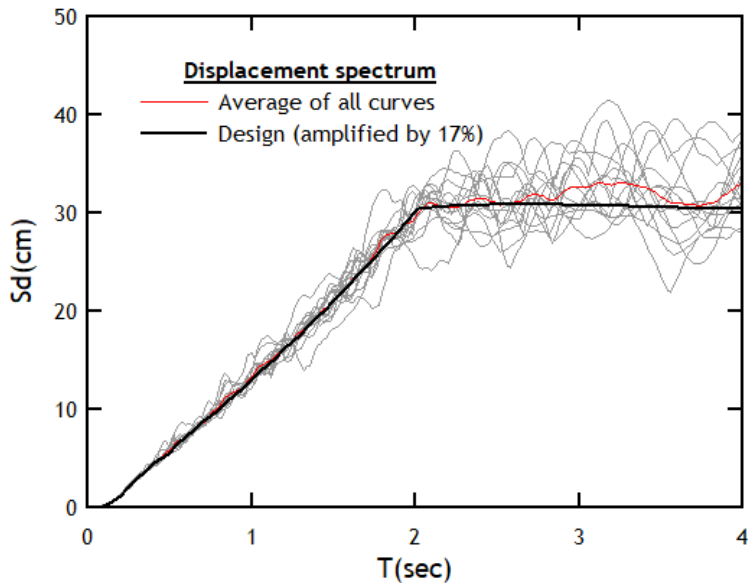
Figure 6. Design elastic spectrum in displacements, amplified by 17% with both average response spectra and those obtained for the records used in the investigation. spectra and those obtained for the records used in the investigation.